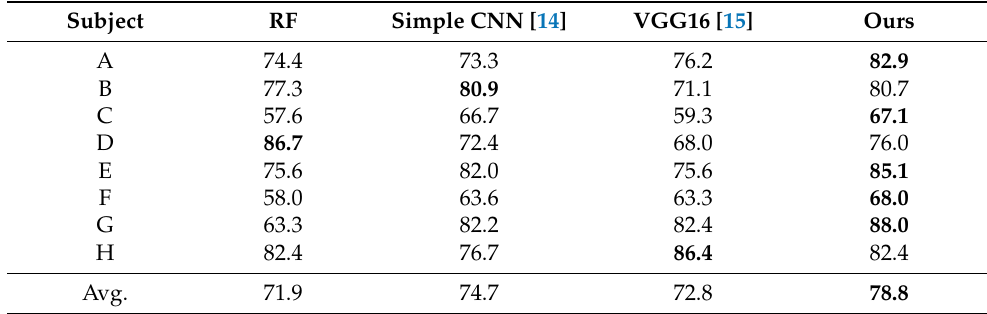
Table 4. Accuracy of each method for each